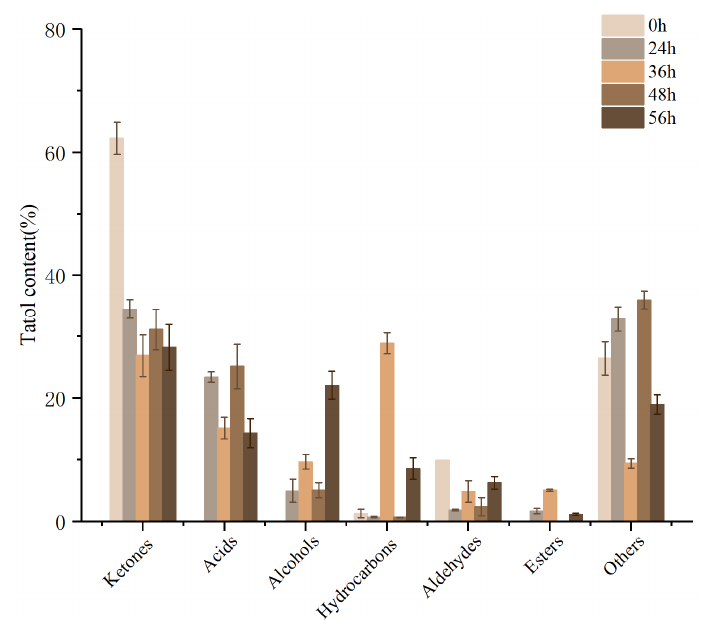
Figure 9. Changes in components of milk during fermentation. Table 9. Five fermentation stages of fermented milk were detected by GC-MS.